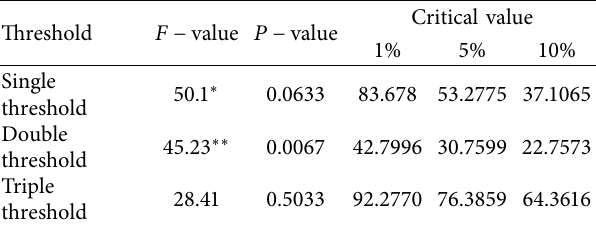
Table 2: Test results of threshold significance.